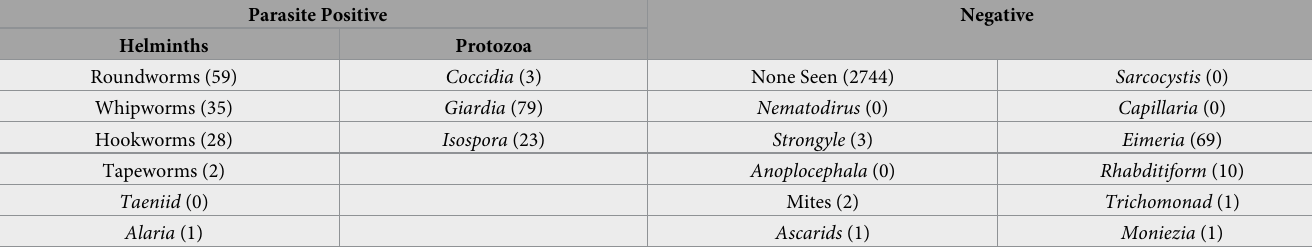
Table 3. Antech fecal results and corresponding parasite categories. Numbers in parentheses denote the number of diagnoses. Parasite Positive Negative